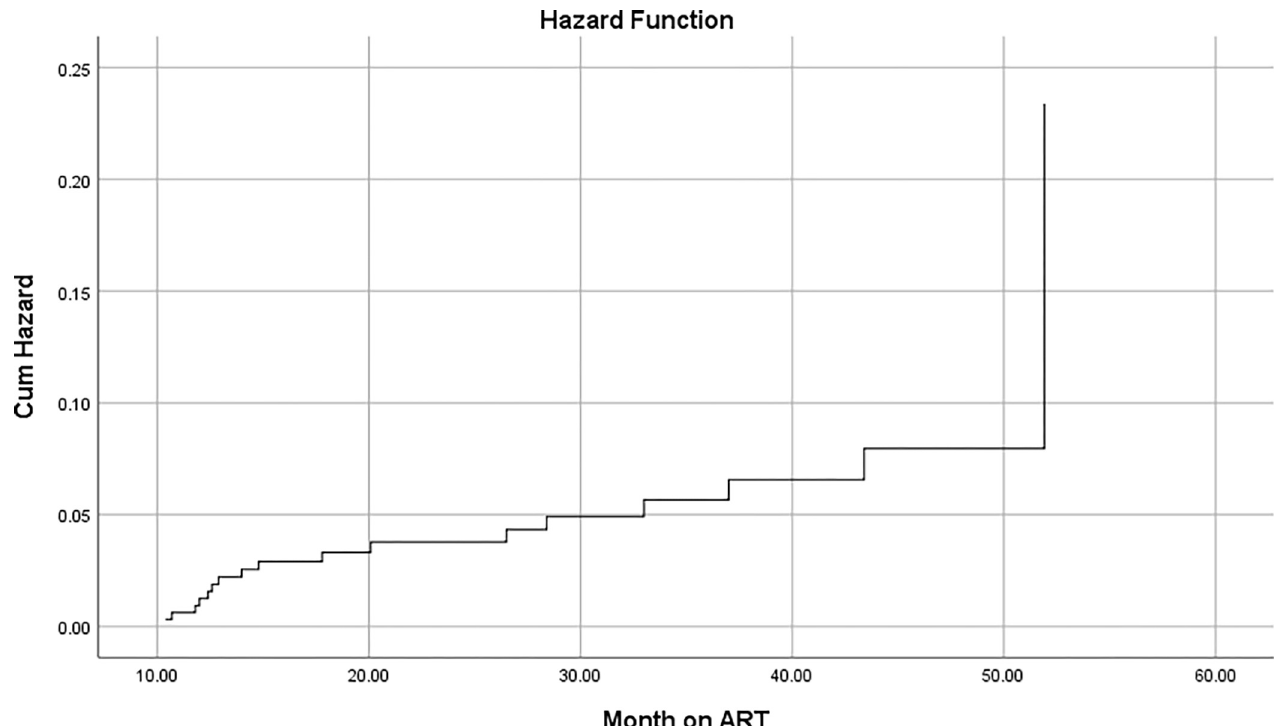
Fig 1. Cumulative incidence of VF among first line adult ART patients in St. Paul’s hospital millennium medical college from July 2016 to December 2020.